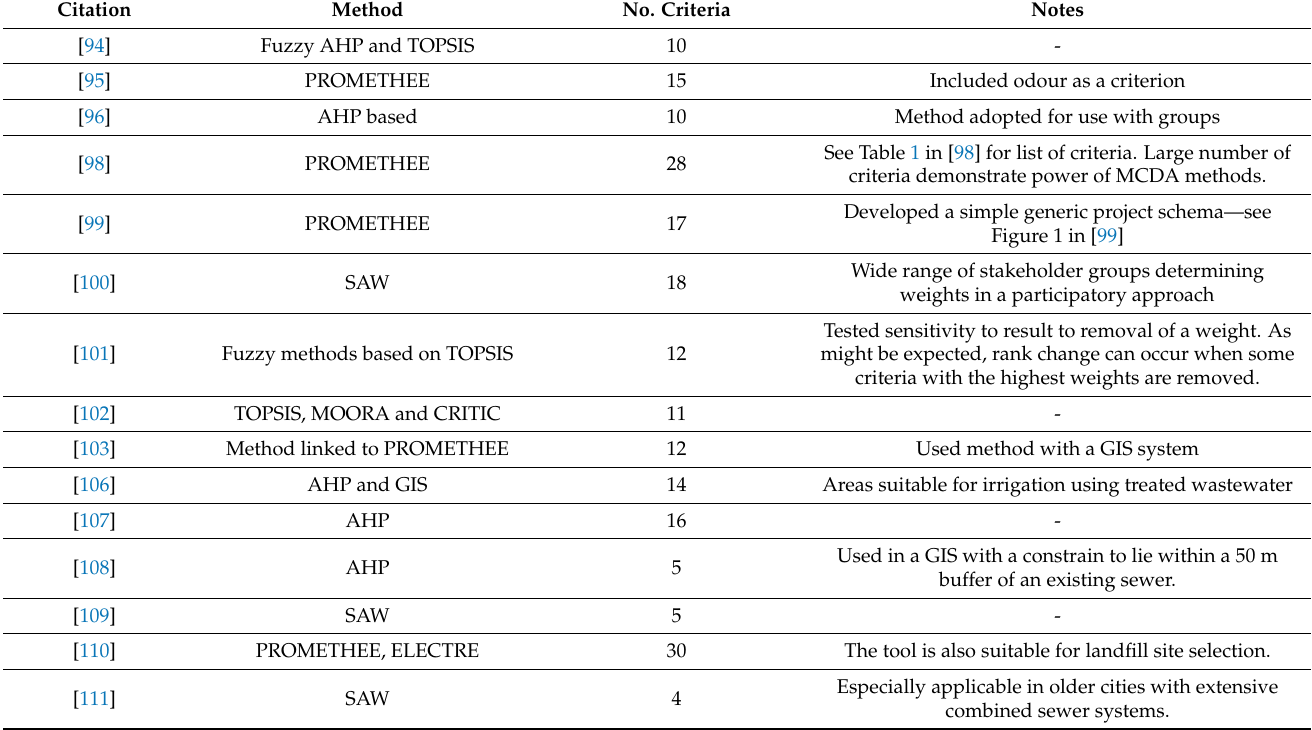
Table 9. Examples of MCDA applications in Sewage Treatment